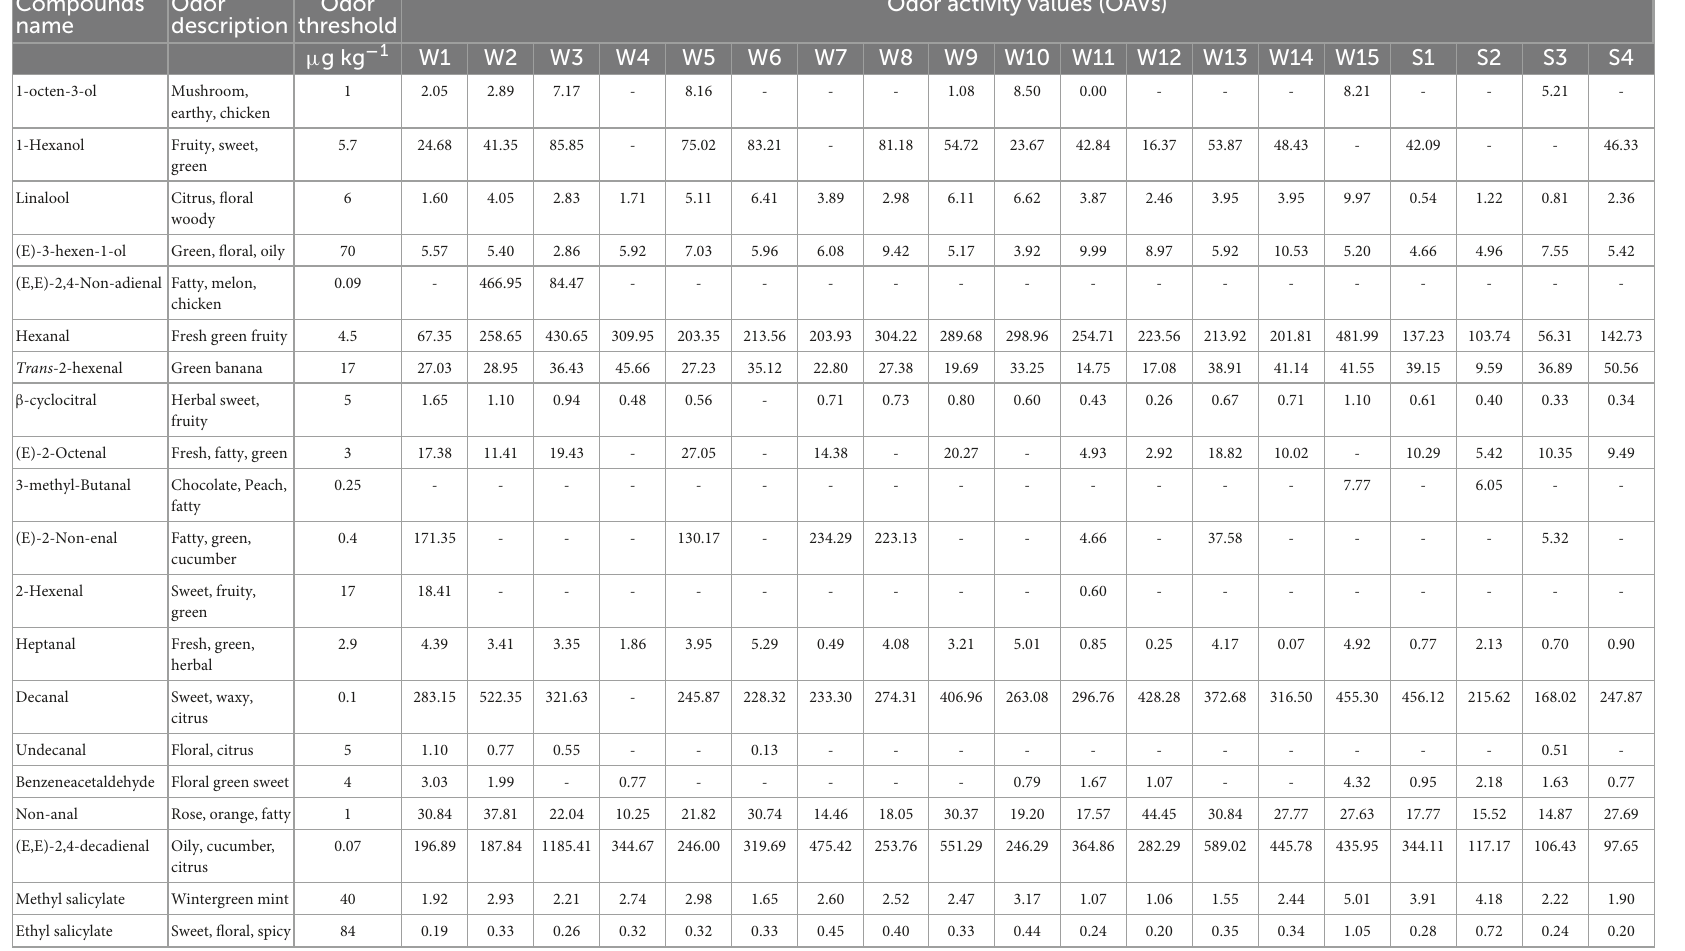
TABLE 2 Odor activity values of 29 volatile compounds in 19 pepper